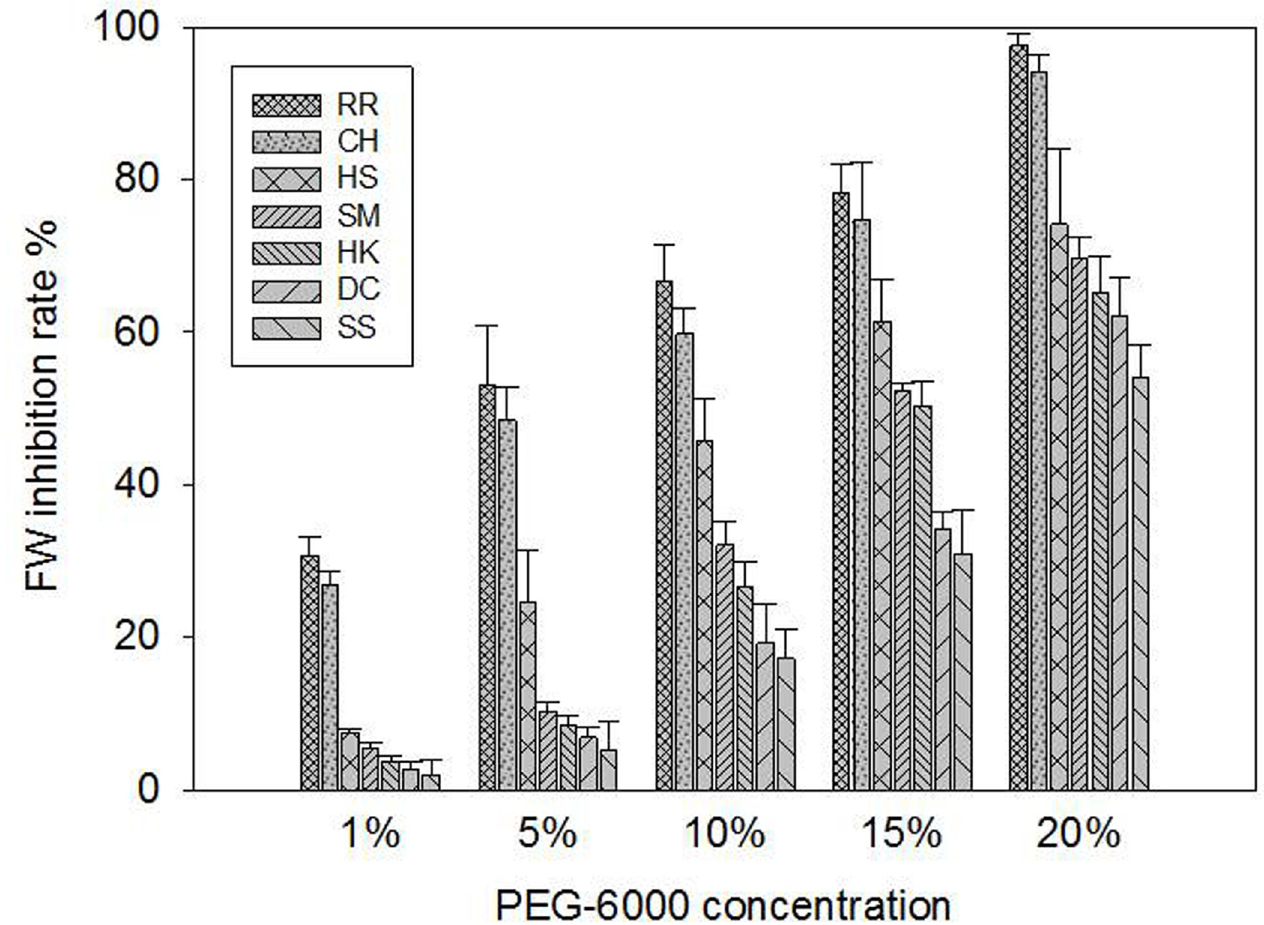
Fig 4. E . crusgalli fresh weight (FW) inhibiton rate (%) under five PEG-6000 concentrations 21 days after treatment. Data are expressed as least square means ± standard error.